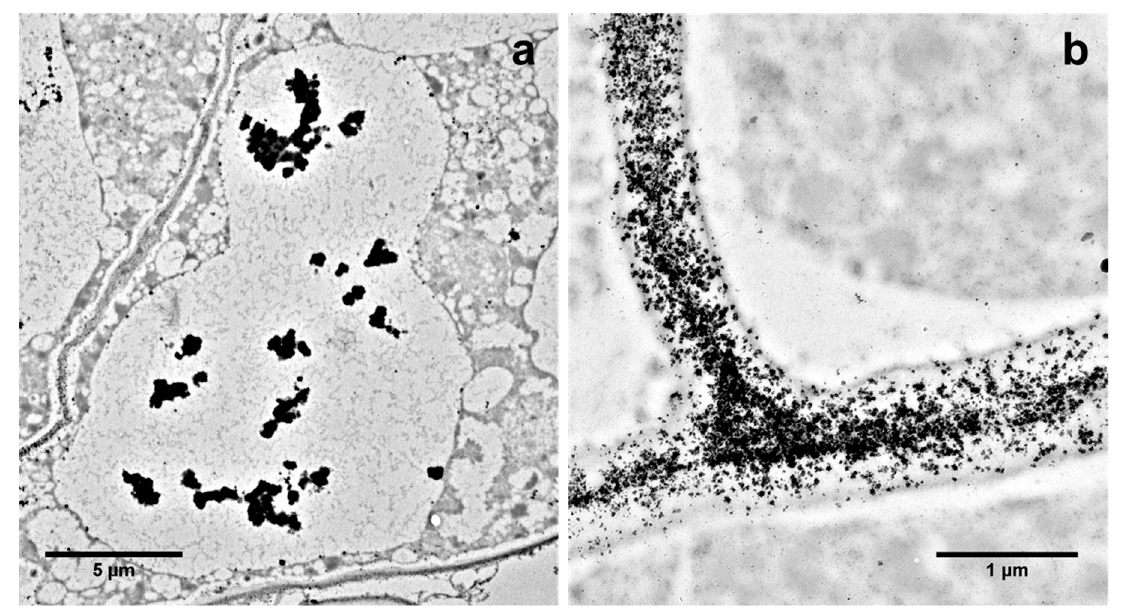
Figure 3. Pb deposition in the vacuoles ( a ) and cell walls ( b ) of V. tricolor cells treated with 2000 µM Pb for 72 h visible in transmission electron microscopy. Based on Sychta et al. [100], new photos were obtained from the private collection of K. Sychta.